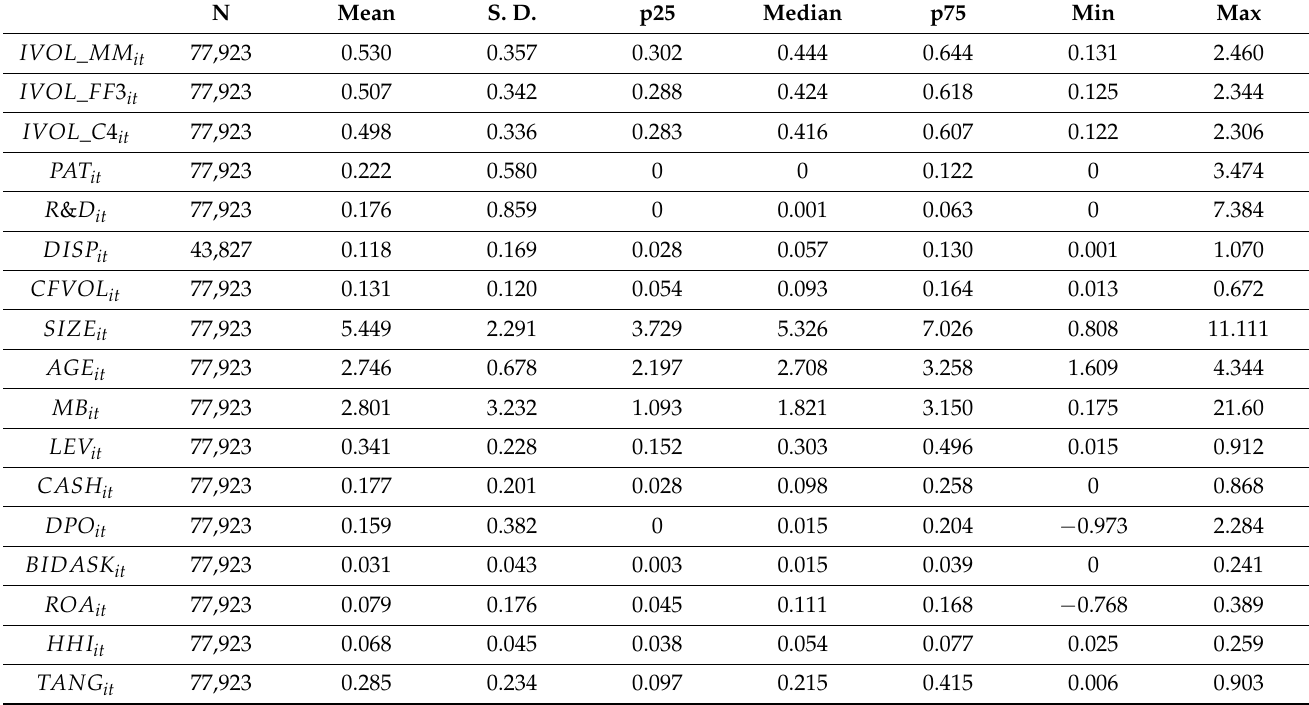
Table 2 shows the summary statistics of the dependent and control variables. To minimize the impact of outliers, all variables are winsorized at the 1st and 99th percentiles. The annualized standard deviation of the residuals of the market model using weekly data ( IVOL _ MM ) is 0.53 over the sample period (the standard deviation of the residuals of the Fama and French three-factor model using weekly data ( IVOL _ FF 3) and the standard deviation of the residuals of the Carhart four-factor model using weekly data ( IVOL _ C 4) are also reported). Table 2. Summary statistics of variables used in the analysis. Variables’ definitions are provided in Appendix